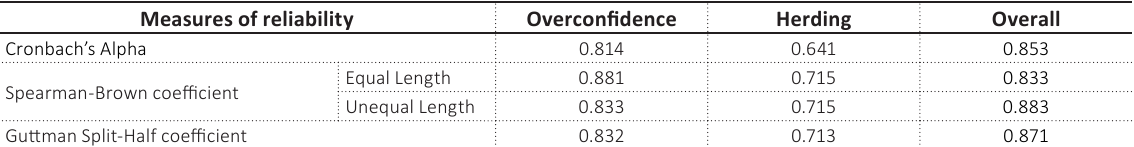
Source: Authors’ calculations.